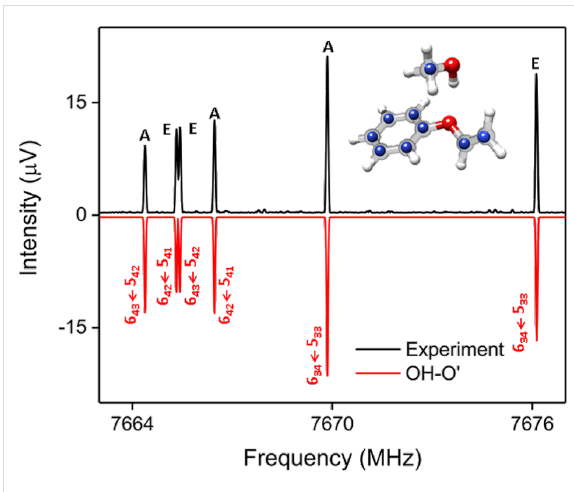
Figure 5: A section of the experimental 2–8 GHz spectrum using a mixture of PVE and MeOH (3 million acquisitions). The upper experi- mental trace in black is compared with simulations, based on fitted pa- rameters that can be assigned to the OH–O’ isomer (complex 1, red) for the PVE–MeOHcomplex. The observed complex has a clear split- ting pattern due to the internal rotation of the methyl group of metha- nol, labeled with A and E. The experimental 13 C positions (blue atoms) (r s substitution structure) deduced from a Kraitchman analysis are compared to the calculated structure at the SCS-CC2/def2-TZVP level of theory and further confirm the observation of the OH–O’